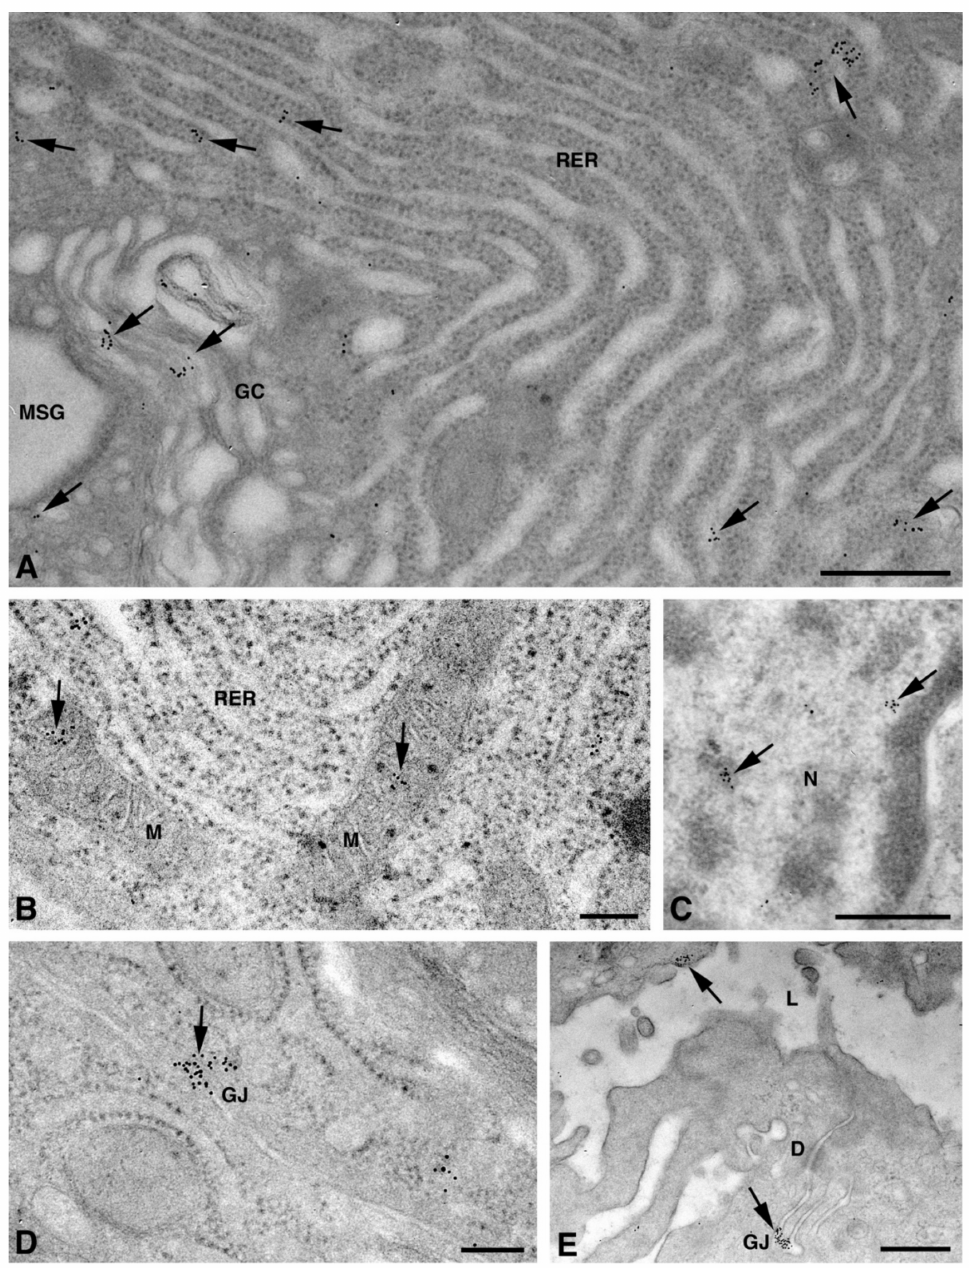
Figure 4. TEM immunogold analysis for Cx32 in NS-hLSGB. Representative images of immunoreac- tions (arrows) at the level of different cell compartments: rough endoplasmic reticulum and Golgi complex ( A ), mitochondria ( B ), nucleus ( C ), and apparent GJ in the lateral plasma membranes ( D ) of mucous cells. In ( E ) gold particles are visible on the apical luminal membrane of a duct cell and on a GJ between the lateral plasma membranes of two duct cells. D, desmosome; GC, Golgi complex; L, lumen; M, mitochondrium; MSG, mucous secretory granule; N, nucleus; RER, rough endoplasmic reticulum. Scale bars ( A , C , E ), 500 nm; ( B ) and ( D ), 200